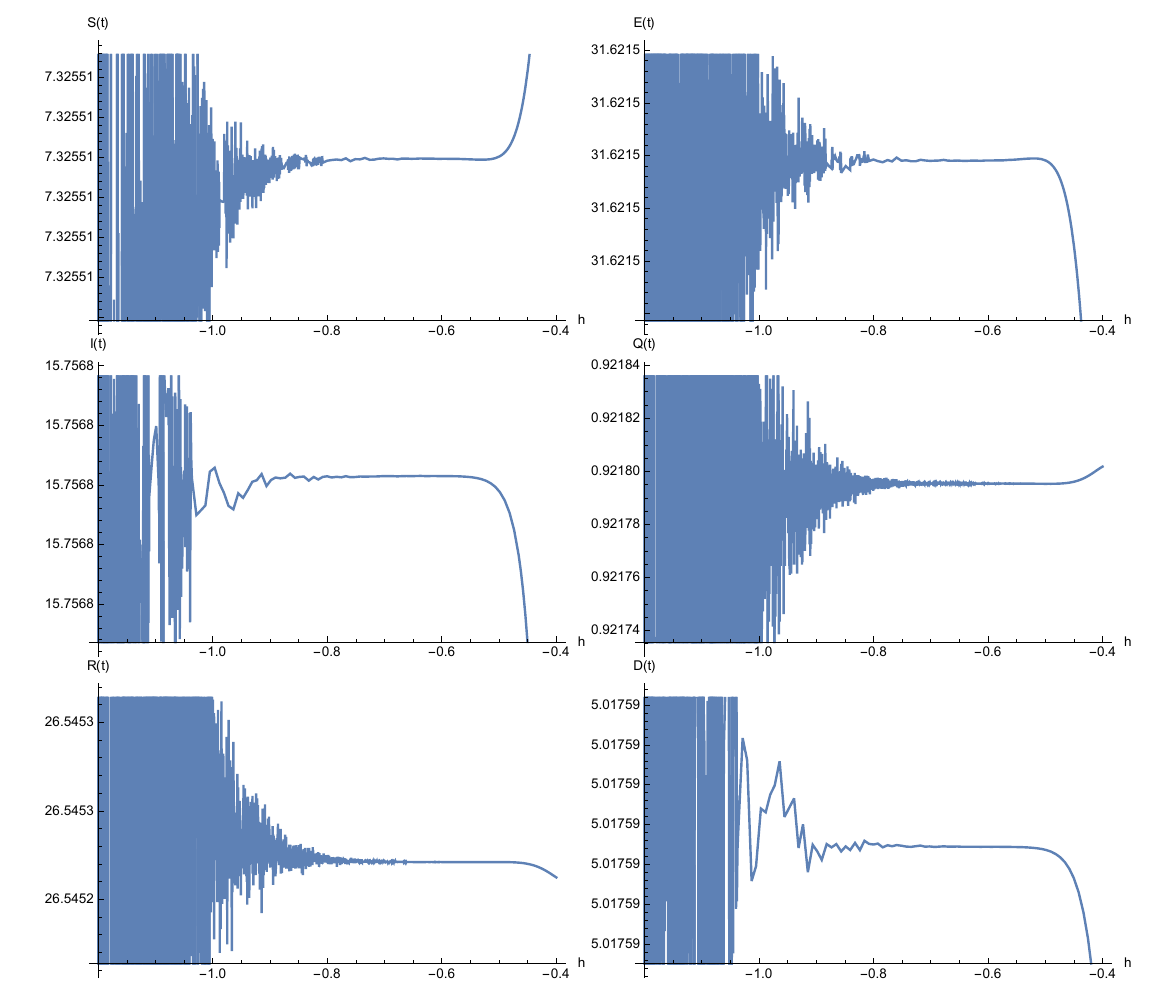
Figure 3. The ¯ h -curves of the approximate solutions obtained form HATM for t = 0.2 and m = 25.